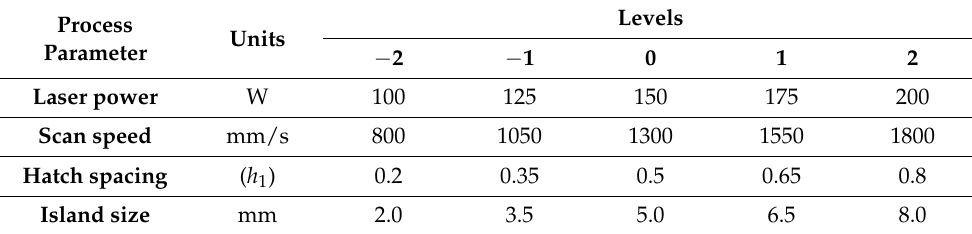
Table 1. The designed process parameters.